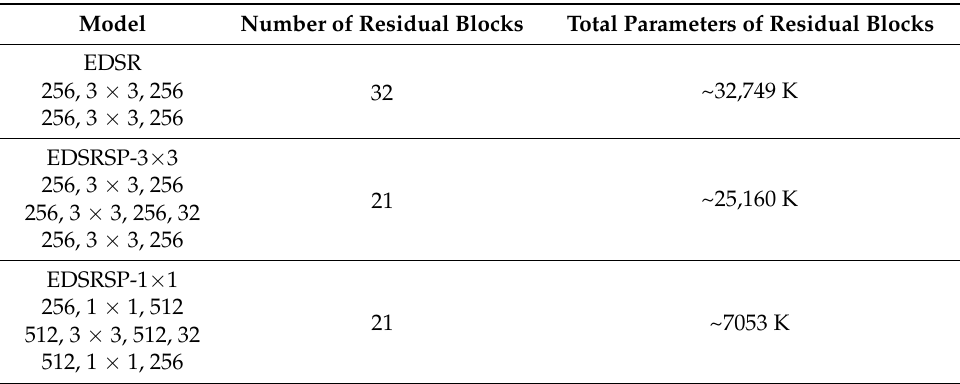
Figure 3. Proposed models. ( a ) EDSRSP-3×3. ( b ) EDSRSP-1×1. Table 1. Parameters of EDSR and our models.